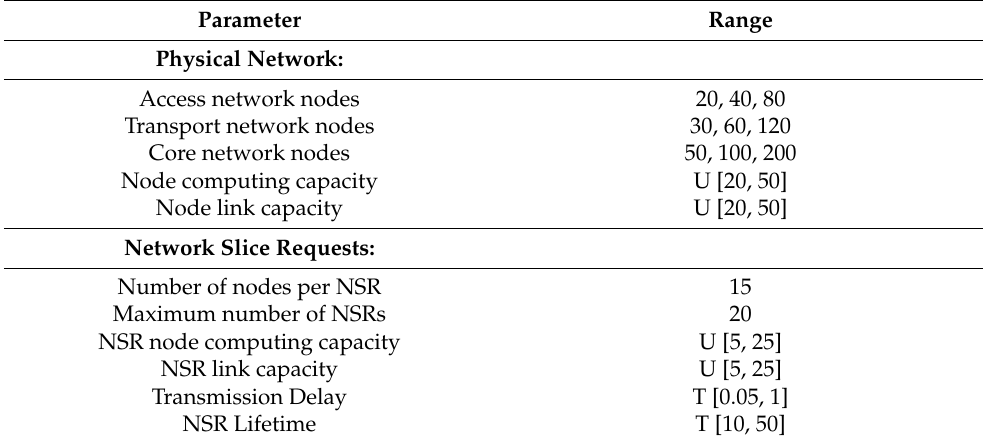
Table 3. Simulation